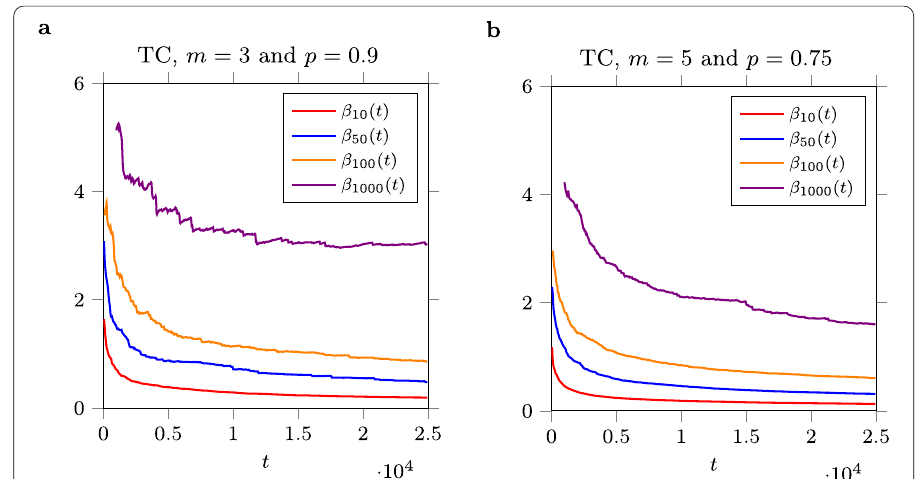
Fig. 14 Evolution of β i in networks based on triadic closure for selected nodes v i , i = 10,50,100,1000 , as t iterates up to 25000. Network in Figure a is modeled with m = 3 , p = 0.9 , while b is simulated with m = 5 , p =